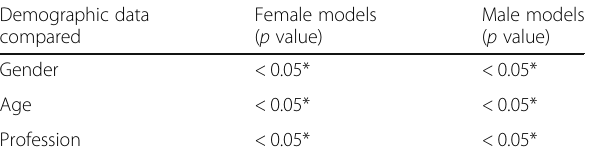
Table 4 Differences in beauty perception of male and female models according to participants ’ gender, age and profession Demographic data compared